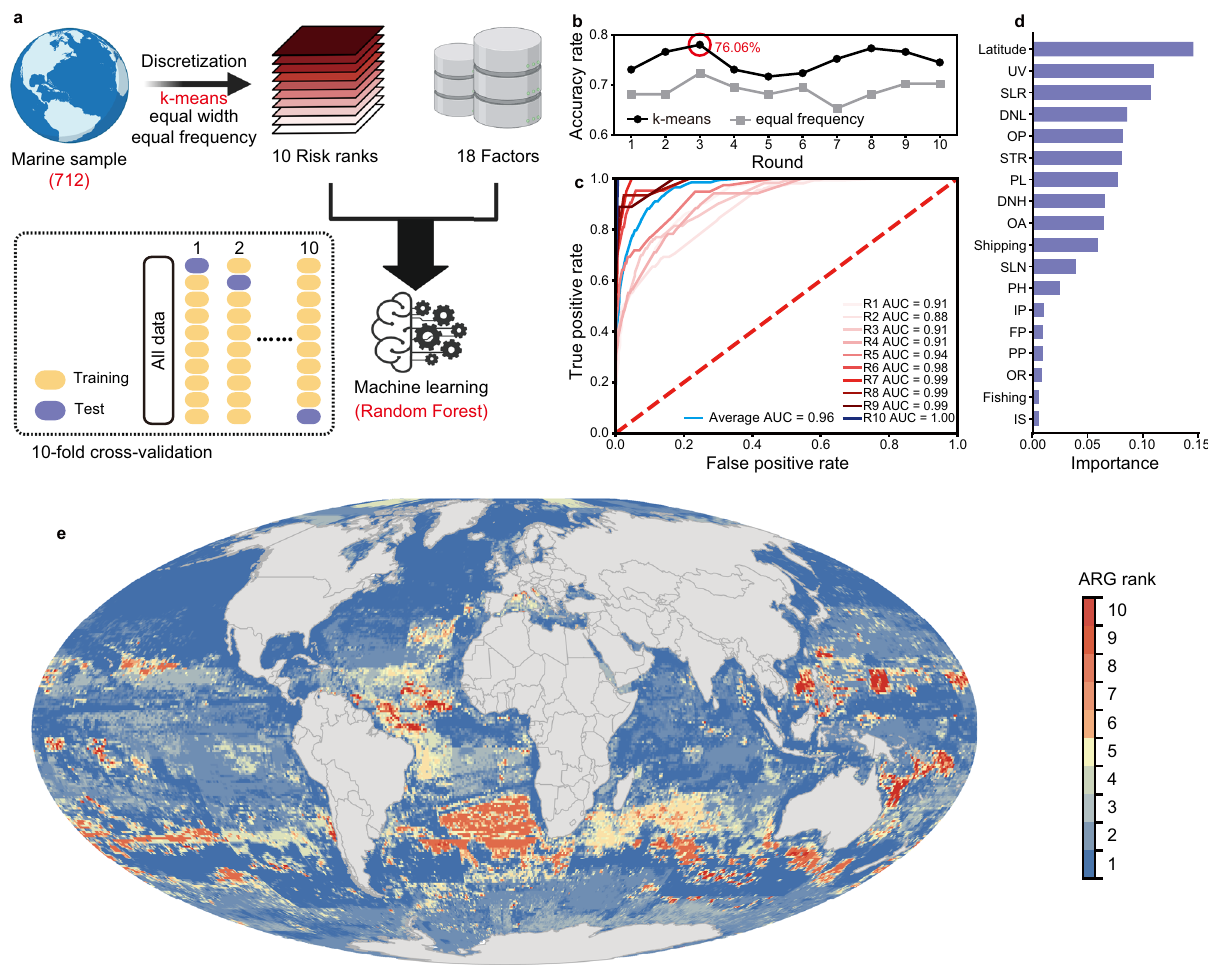
Fig. 4 Global mapping of antibiotic resistance threats in marine habitats. a Machine learning were trained by 712 samples from marine habitats and used to predict the antibiotic resistance threats in global marine habitats. b Accuracy rate of machine learning with different discretization methods. K -means exhibited higher accuracy rate than equal frequency and the best model (accuracy rate = 76.06%) were chosen for the further prediction. c The ROC plots con fi rmed the high performance of the best model in classi fi cation of risk ranks. d Latitude as well as the climate change stressors exhibited the high importance in predicting the antibiotic resistance risk. The full name of each indicator can be found in Supplementary Data 12. e The map of ARG risk in marine habitats with prediction results by machine learning, which was drawn by ArcGIS in 20 ′ × 20 ′